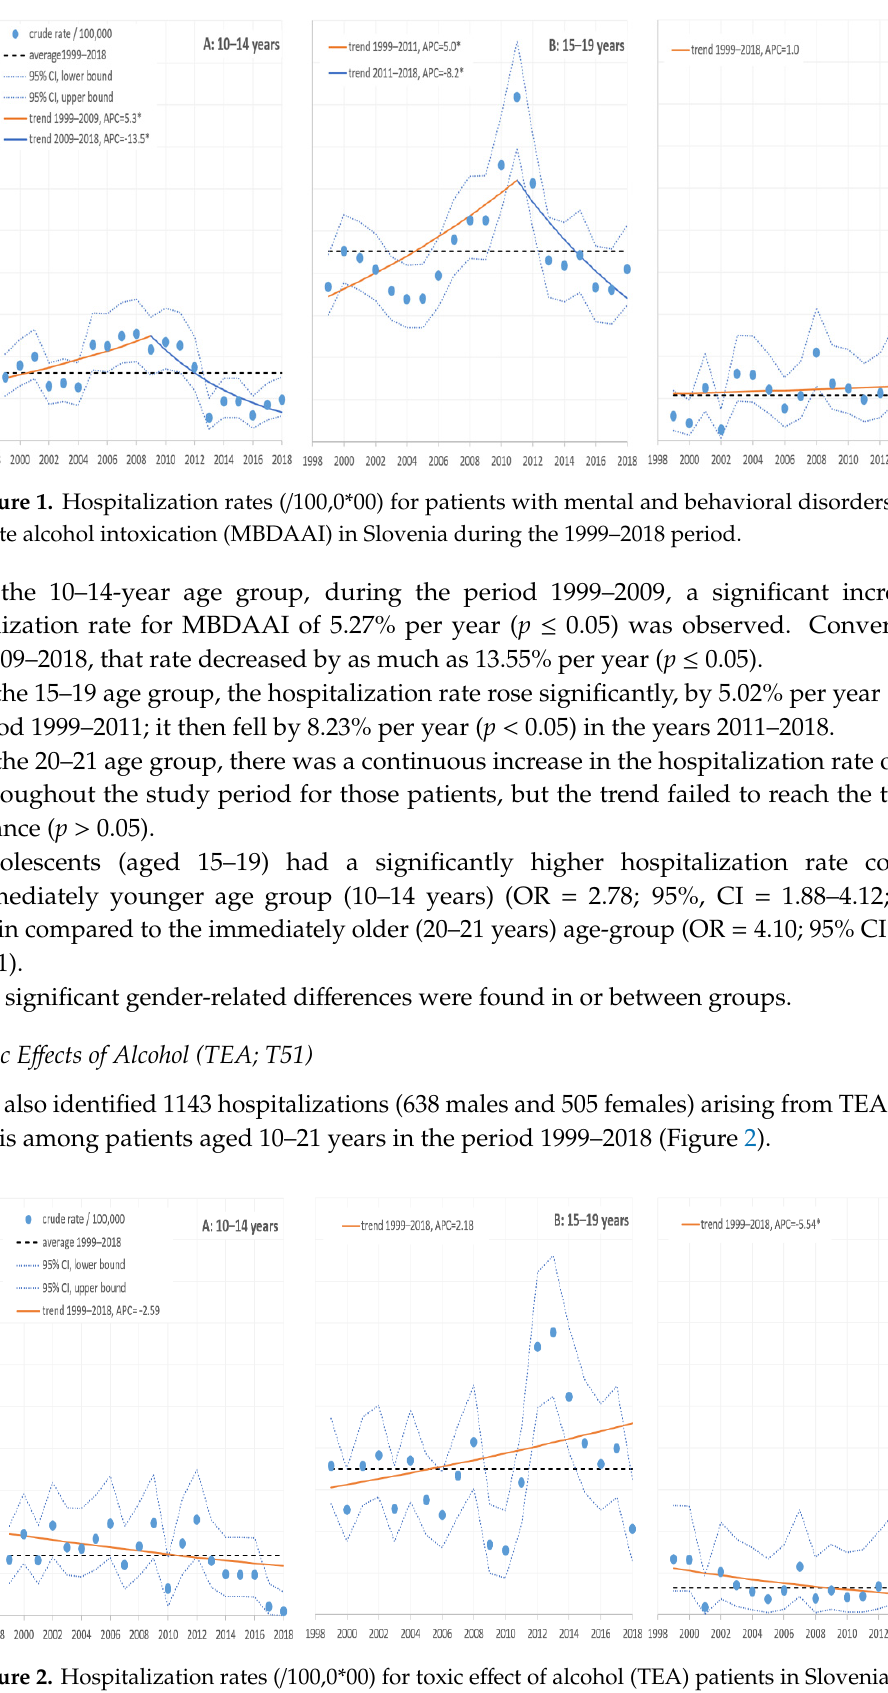
Figure 2. Hospitalization rates (/100,0*00) for toxic effect of alcohol (TEA) patients in Slovenia during the 1999–2018 period.